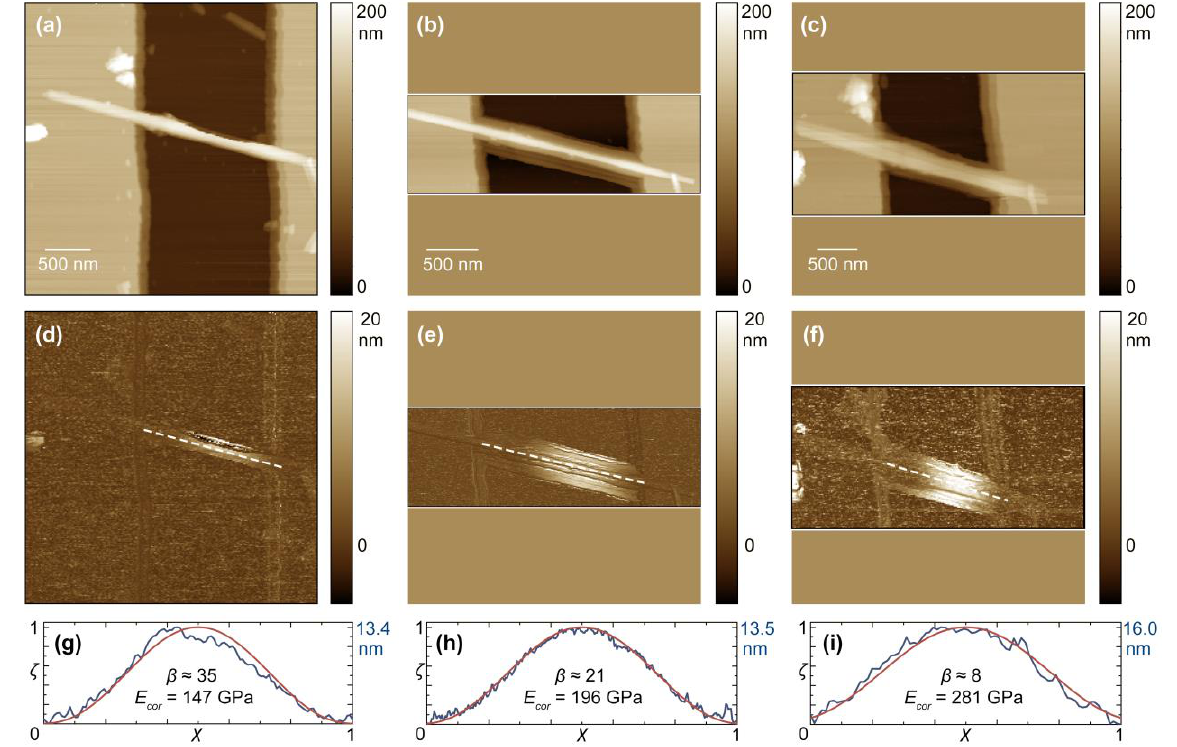
Figure 1. AFM ( a ), ( b ), ( c ) height and ( d ), ( e ), ( f ) corrected deformation images of the Mg 3 Si 2 O 5 (OH) 4 nanoscroll on a TGZ2 silicon grating before treatment, after heat treatment at 400 °С, and after heat treatment at 600 °C, respectively; ( g – i ) normalized profiles of corrected deformation of the nanoscroll (blue) and theoretical profiles according to the expression (5) (red), the extraction sites of the profiles are shown by dashed lines on ( d – f ), respectively. AFM imaging was performed with Peak Force Amplitude and Frequency — 150 nm and 1 kHz, respectively. The other scanning parameters were as follows: (before heat treatment) Peak Force Setpoint — 20 nN, Scan Rate — 0.3 Hz, Samples/Line — 256, Lines — 256; (400 ° С ) 25 nN, 0.3 Hz, 512, 171; (600 ° С ) 40 nN, 0.2 Hz, 256, 124.